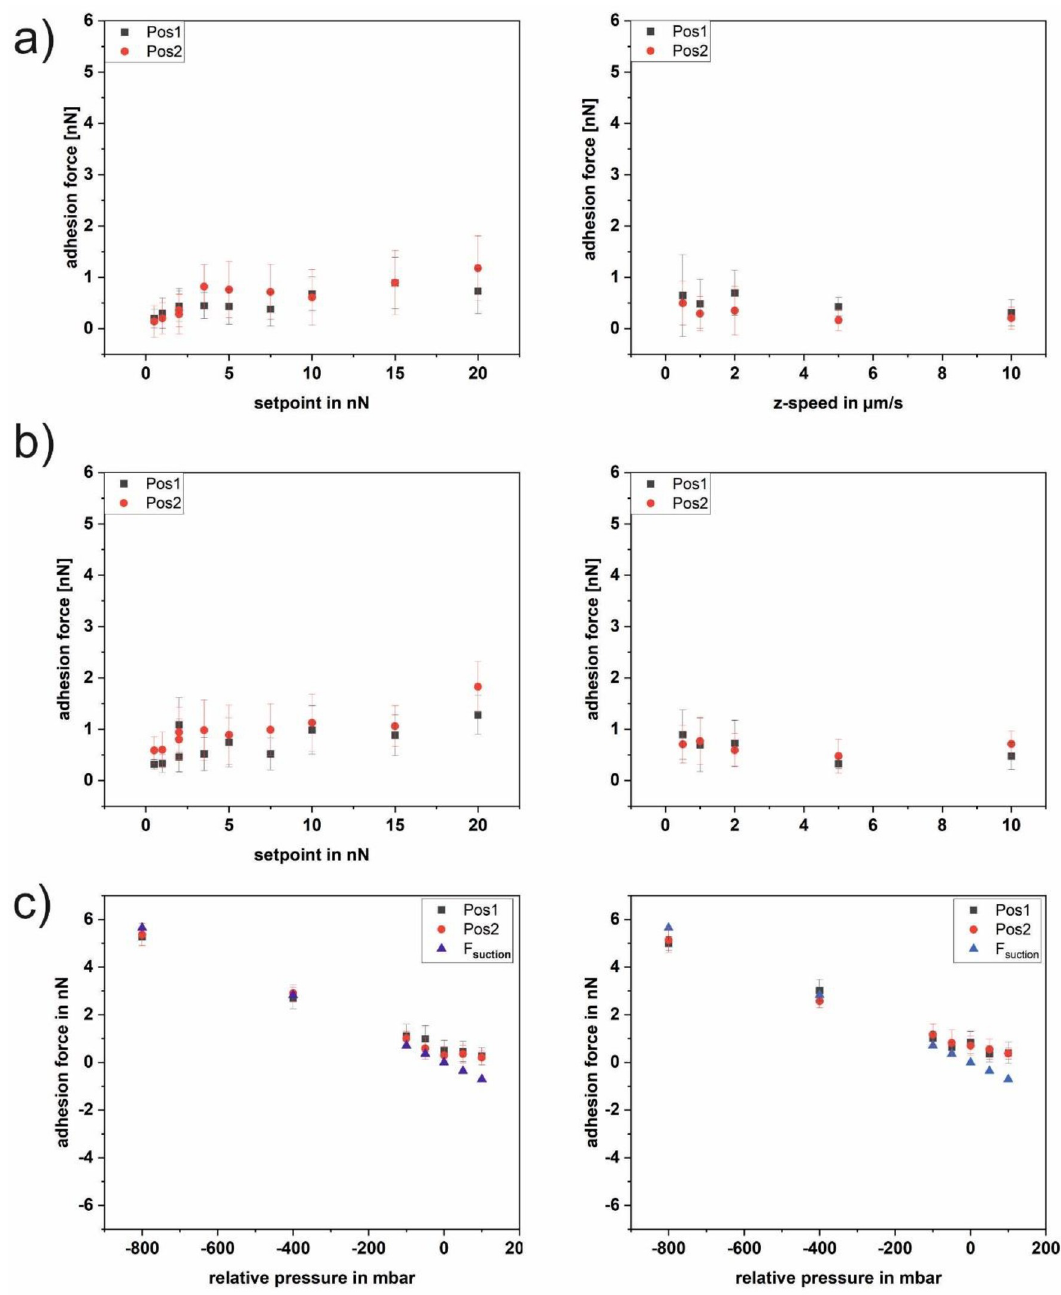
Fig 1. Adhesion force of a blank FluidFM nanopipette on glass. Each data point comprises 25 force-distance curves. a) no pressure (0 mbar) applied. Left as a function of the setpoint, right as a function of the z-speed. b) pressure of -50 mbar applied;. Left as a function of the setpoint, right as a function of the z-speed. c) as a function of applied pressure. Two different sets of parameters were used. Left setpoint 2 nN, z-speed 2 μ m/sec, right setpoint 5 nN, z-speed 5 μ m/sec, both including the curve for F suction calculated according to